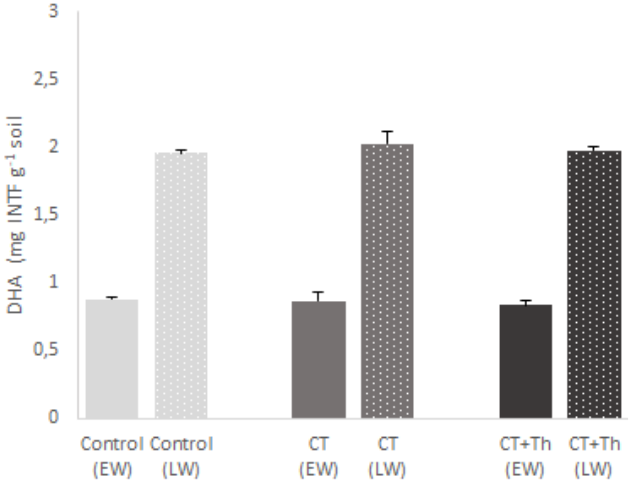
Figure 4. Effect of different compost tea (CT) treatments on soil dehydrogenase activity (DHA) (mg INTF g − 1 soil) Bars are mean values n=3. Error bars indicate standard deviation. Control: sprayed distilled water (12 m 3 per ha); CT: sprayed compost tea (12 m 3 per ha); CT + Th: sprayed compost tea (12 m 3 per ha) and T. harzianum T-78 (5 × 10 8 cfu mL − 1 per ha). EW: early winter and bars without points; LW: late winter and bars with points. (Treatment: F = 2.145; p = 0.160; Cycle: F = 5604.522; p = 0.000; Interaction: F = 2.167; p = 0.157). Di ff erent lowercase letters indicate di ff erences between treatments ( p ≤ 0.05) in EW and di ff erent uppercase letters indicate di ff erences between treatments ( p ≤ 0.05) in LW.